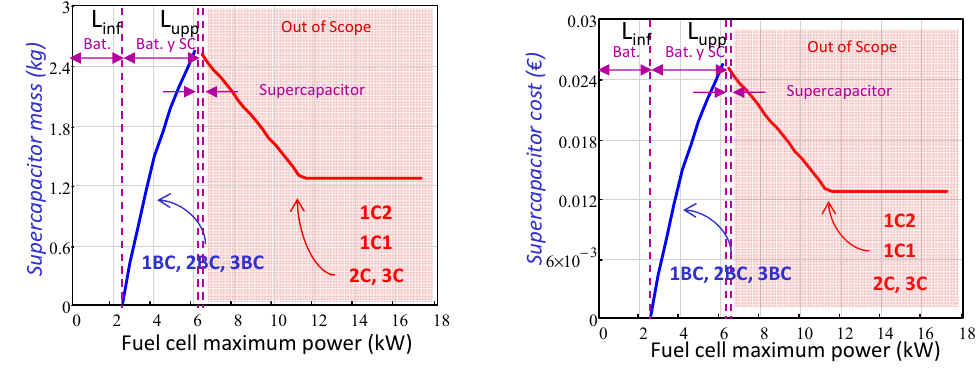
Figure 12. Supercapacitors mass and cost.